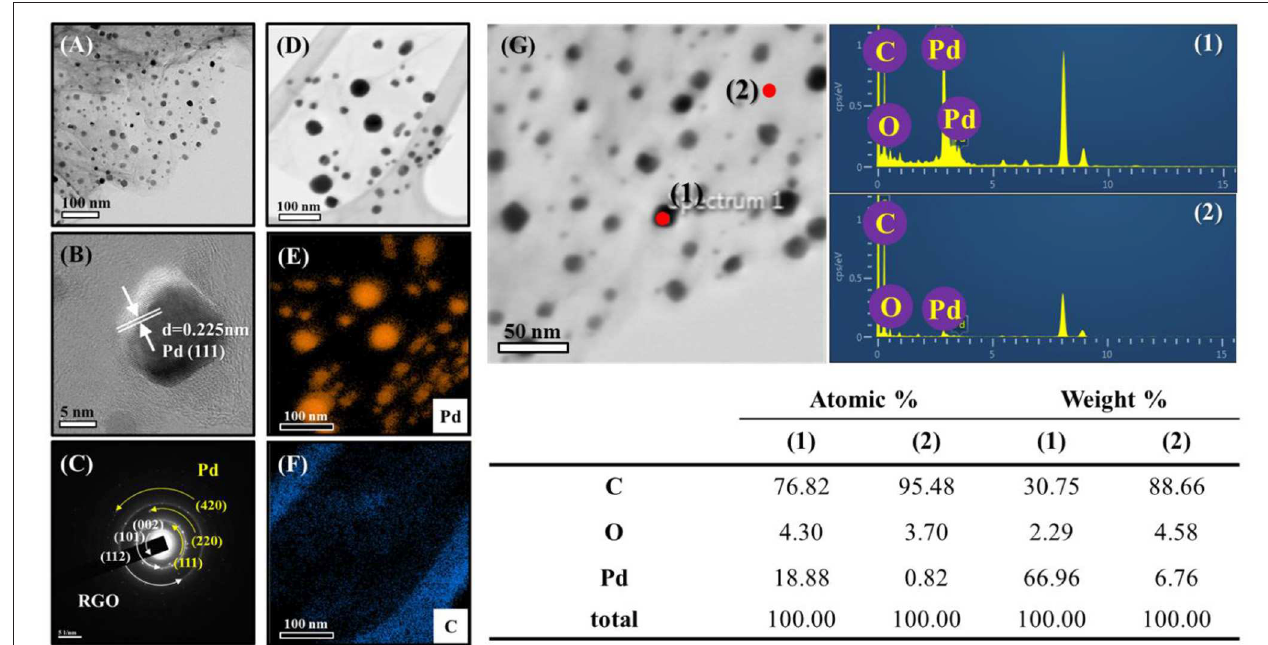
FIGURE 4 | (A) TEM images of Pd-RGO-0 and the corresponding (B) lattice-resolved-TEM image (C) SAED pattern. (D) TEM image for EDS analysis. EDS elemental mapping of (E) Pd and (F) C. (G) EDS analysis with the corresponding compositional Table.